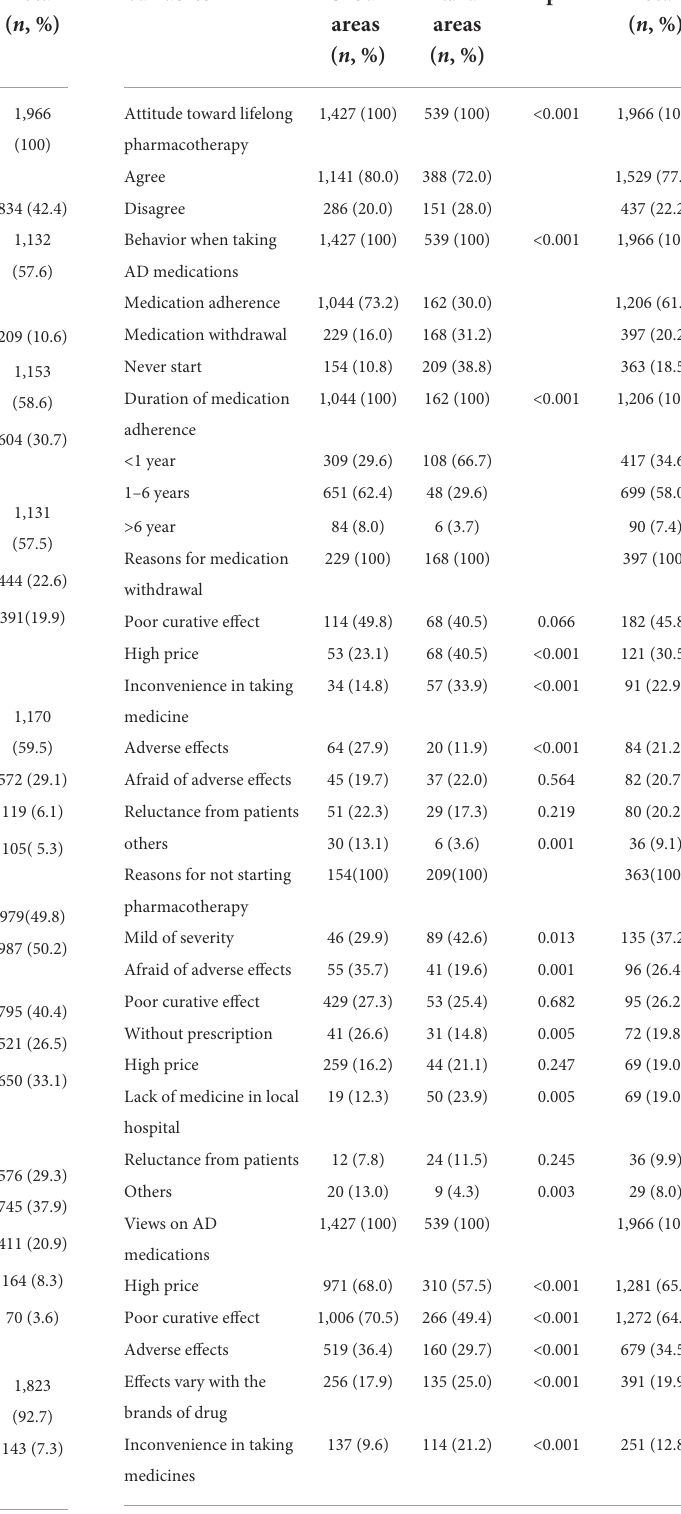
TABLE 2 The characteristics about treatment of the urban and rural people with